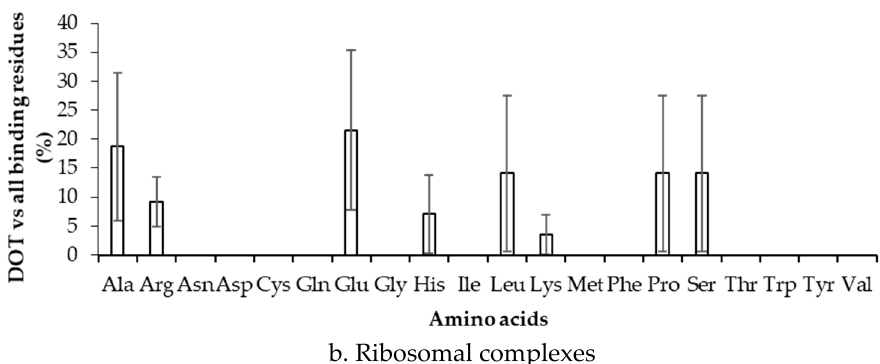
Figure 4. Frequency of DOT regions by contact residues for ( a ) non-ribosomal and ( b ) ribosomal complexes.